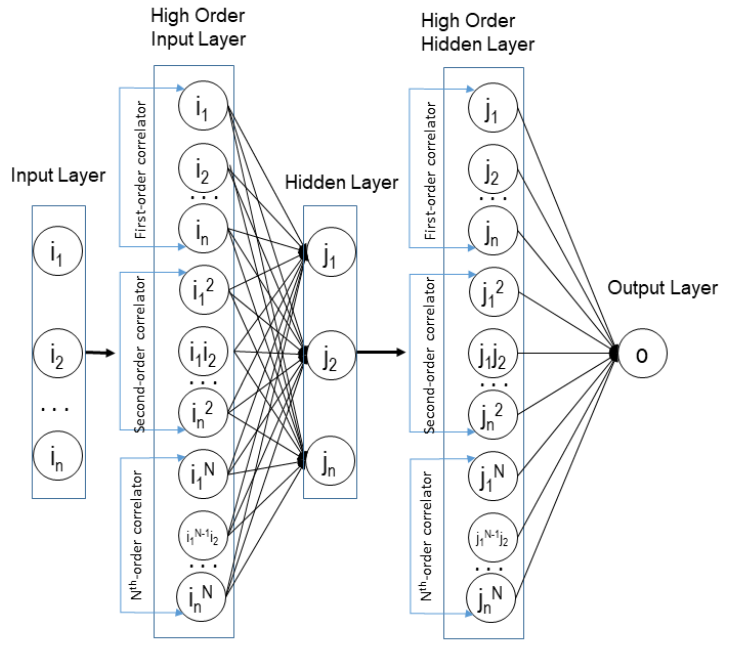
Figure 1. Higher-order neural network architecture.